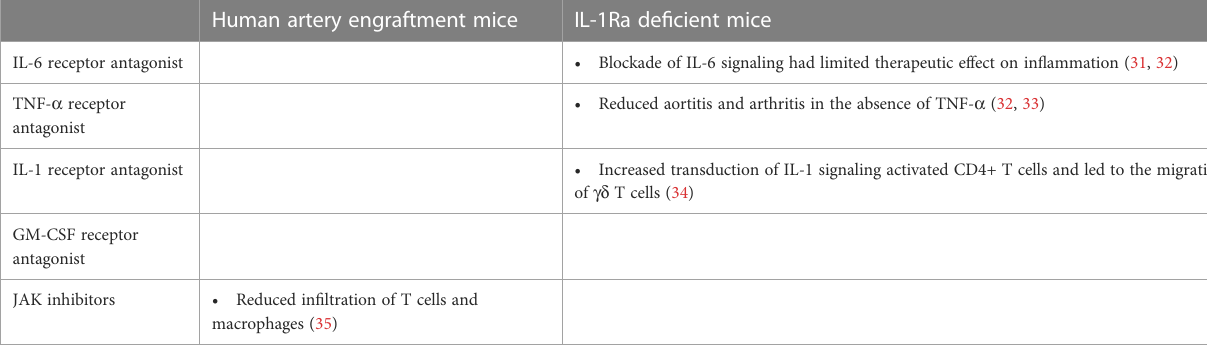
TABLE 2 Molecular pro fi les in mouse models of large vessel vasculitis associated with treatments. Human artery engraftment